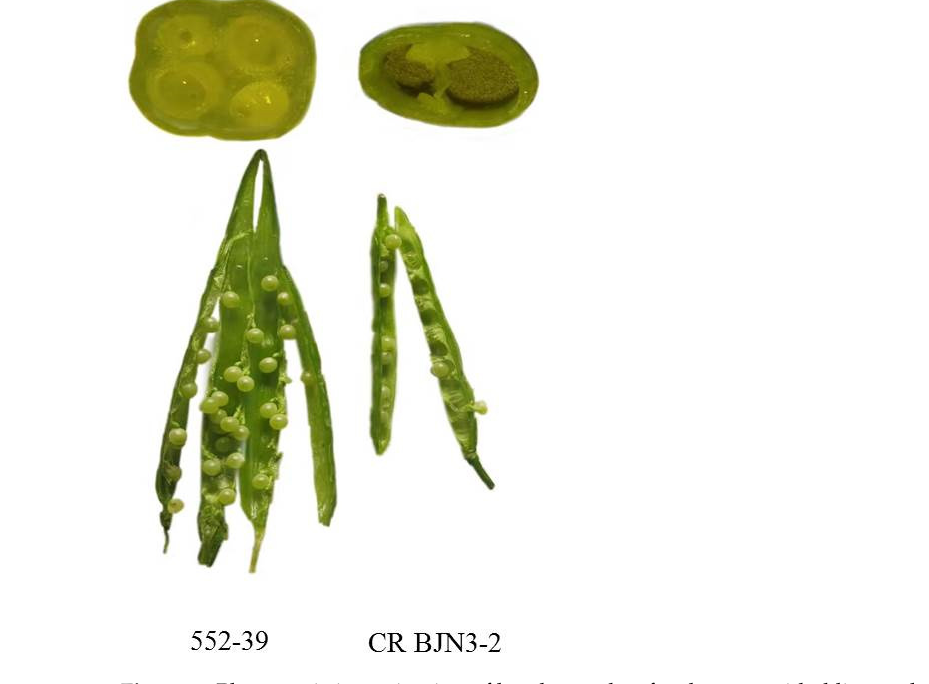
Figure 7. Phenotypic investigation of locule number for the pyramided line and two parental lines. CR BJN3-2: recurrent parent; 552-39: selected pyramided line. Table 3. Self-compatibility index (SCI) of the pyramided line 552-39 and two parental lines (CR BJN3-2 and KYS). Table 4. Agronomic trait evaluation of recurrent parent and pyramided line.